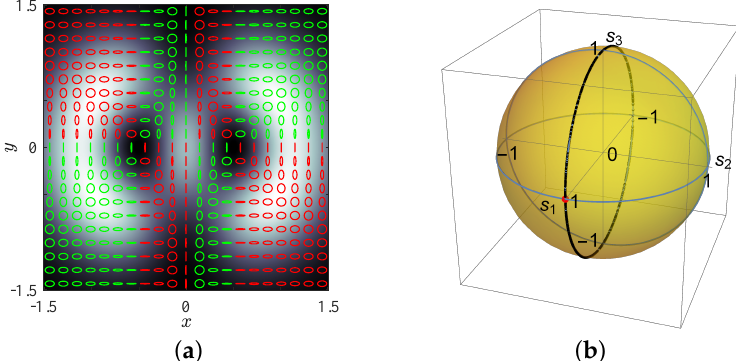
Figure 1. ( a ) Transverse intensity and polarization pattern for the field in Equation (9) where handedness is codified by the color of the ellipses (green = right, red = left, and red is also used for linear polarization), and distances are normalized to the beam spot size; ( b ) corresponding states of polarization represented by black dots on the Poincaré sphere; the red dot indicates horizontal linearly polarized